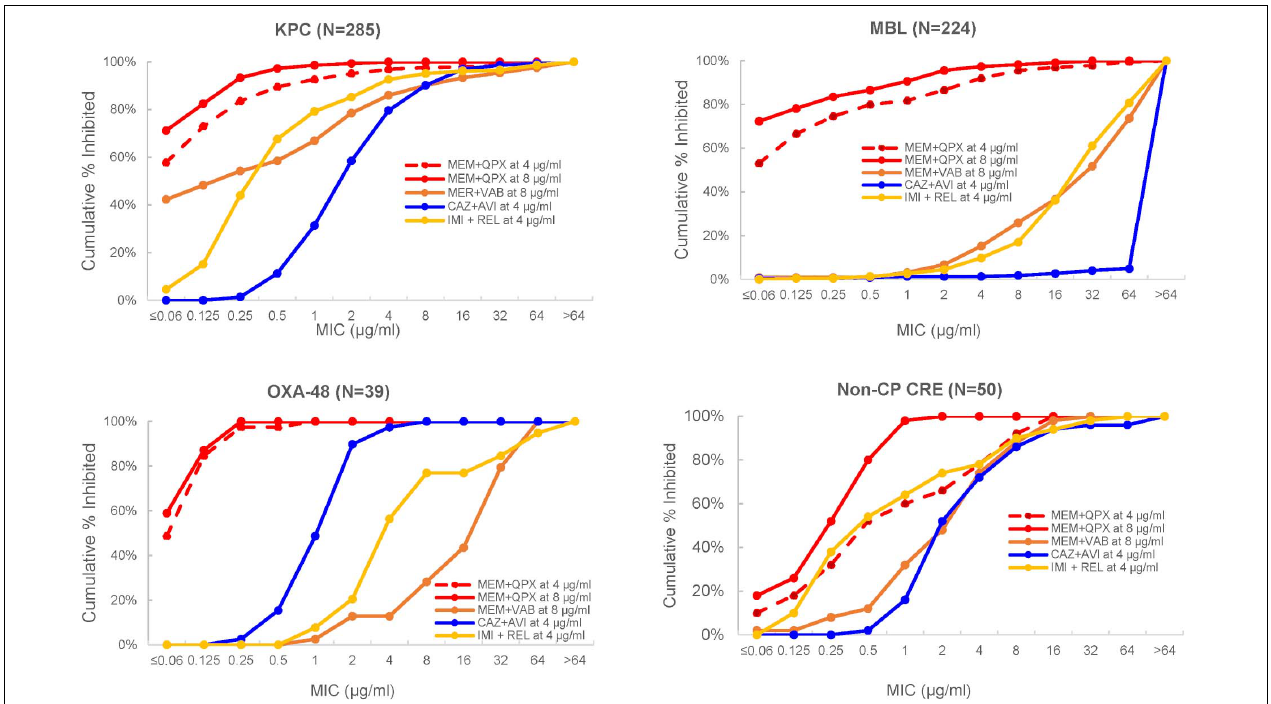
FIGURE 7 | MIC distributions of various β -lactam/BLI combinations against carbapenem-resistant Enterobacterales according to the type of CRE. MEM, meropenem; CAZ, ceftazidime; IMI, imipenem; AVI, avibactam; QPX, QPX7728; REL, relebactam; Non-CP CRE, non-carbapenemase producing CRE. Adapted with modifications from Nelson et al.